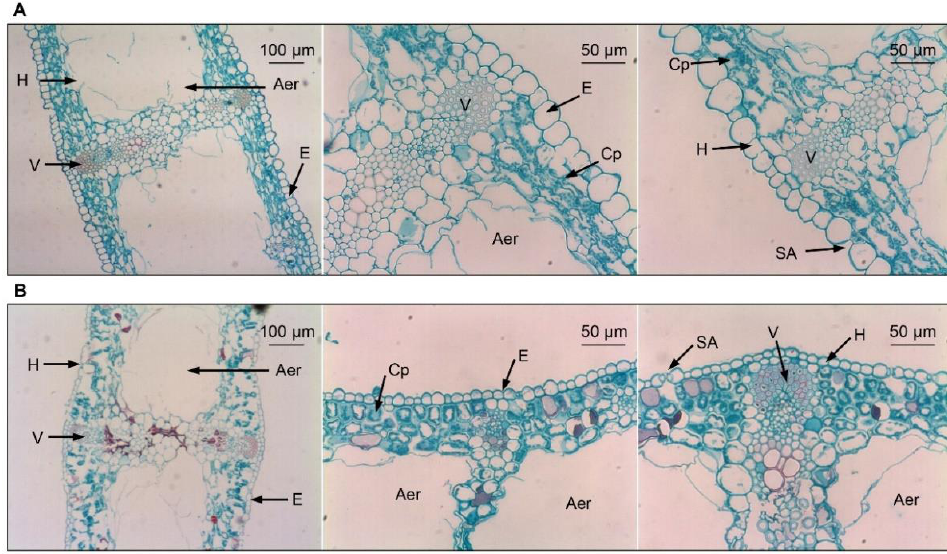
Figure 2. Leaf microstructures of evergreen and deciduous irises after exposure to low temperatures (during cold acclimation on 27 November 2021). ( A ) Leaf microstructures of evergreen irises. ( B ) Leaf microstructures of deciduous irises. Aer, aerenchyma; Cp, chloroplast; E, epidermis; H, hypodermis; SA, stomatal apparatus; V, vascular bundle.